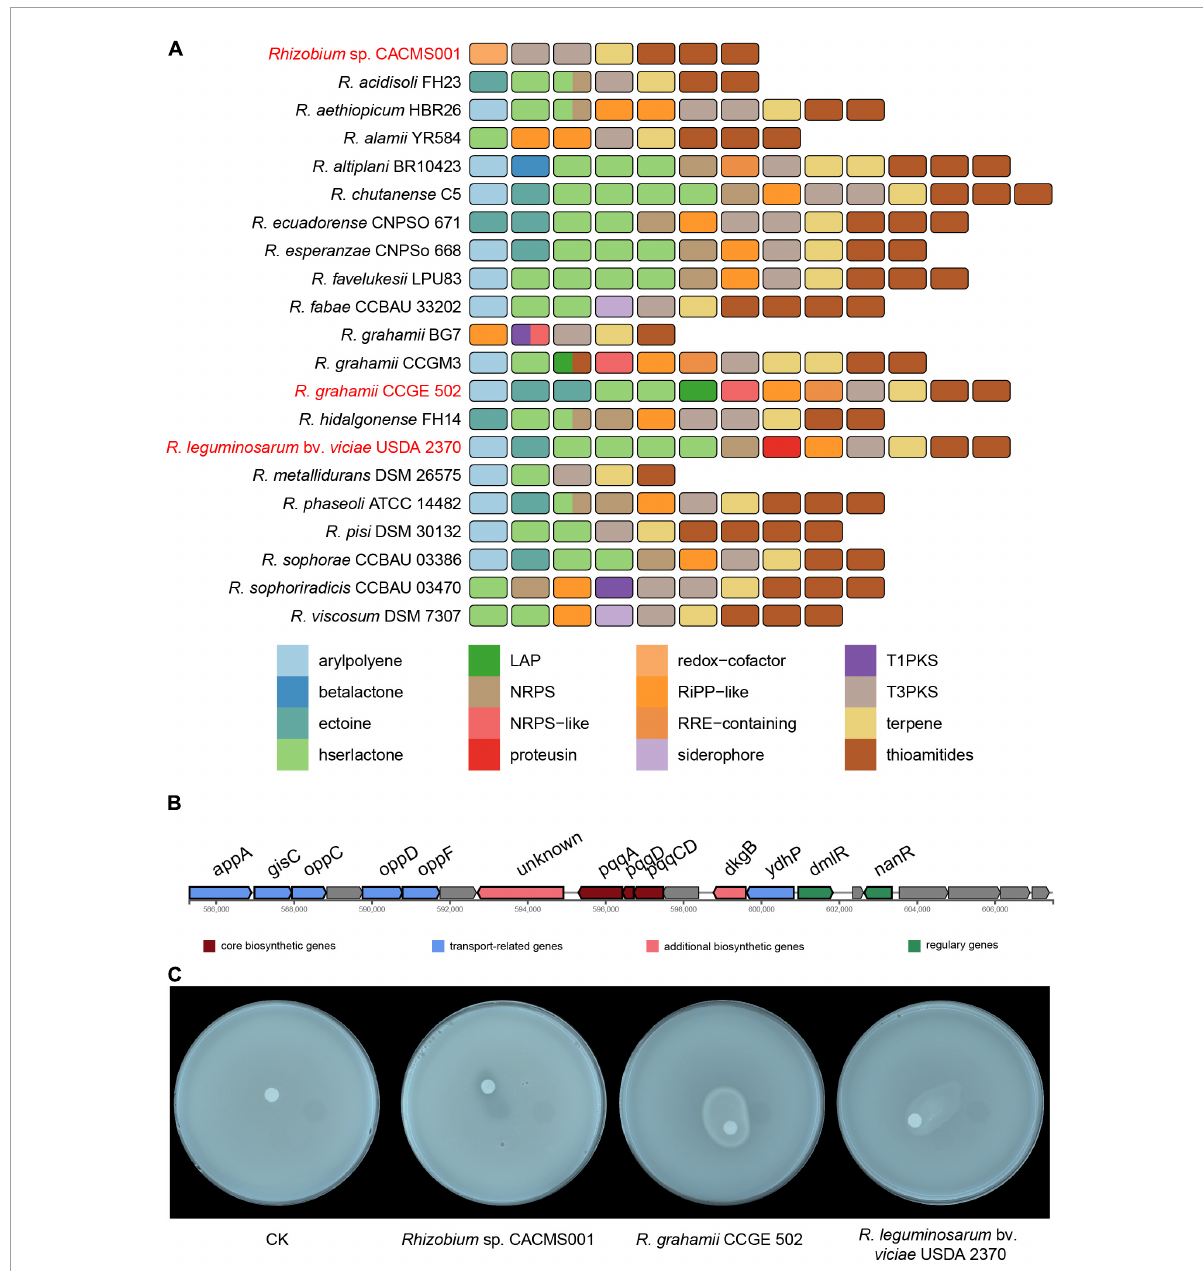
FIGURE8 Comparison of secondary metabolite biosynthetic gene clusters in Rhizobium species. (A) Comparison of biosynthetic gene clusters between strain CACMS001 and other closely related species. (B) PQQ biosynthetic gene cluster in strain CACMS001. (C) Phosphate solubilizing by the strain CACMS001 on Pikovskaya